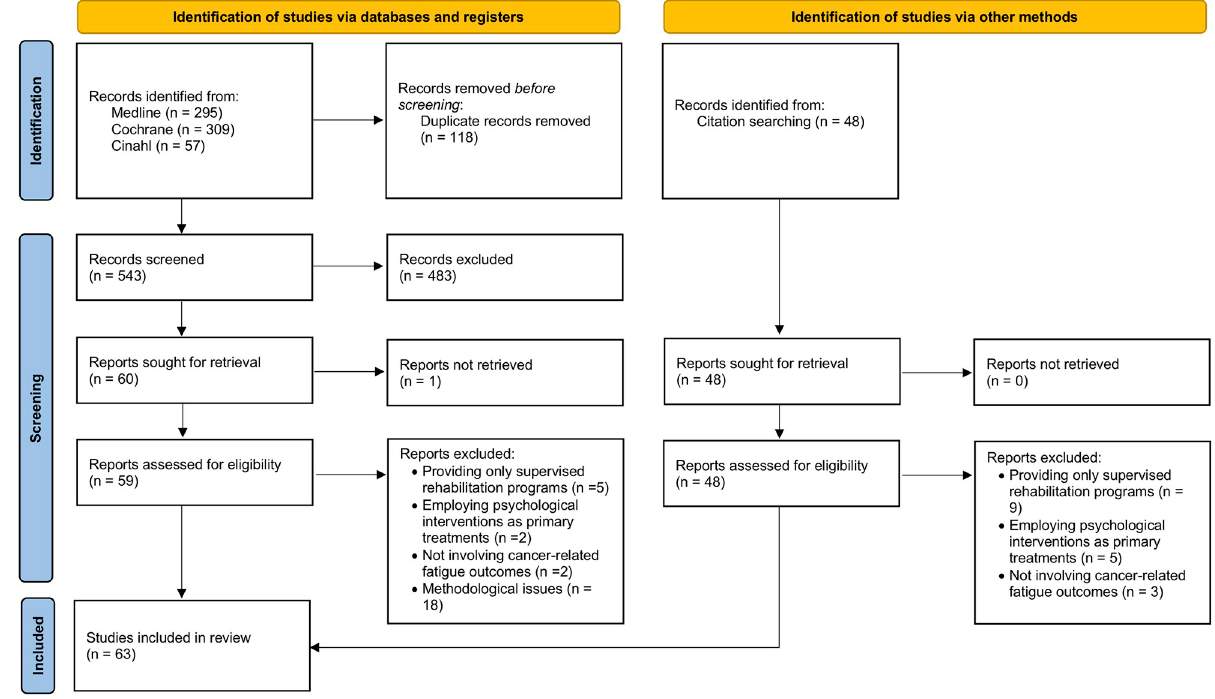
Fig 1. Flow chart of the literature search on self-managed physical activities for cancer-related fatigue management.